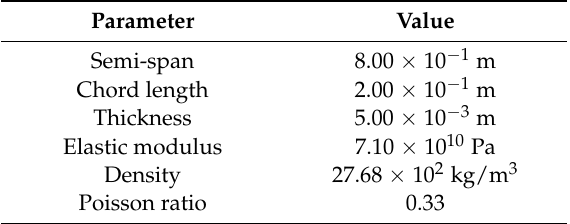
Table 1. The geometric and material parameters of the